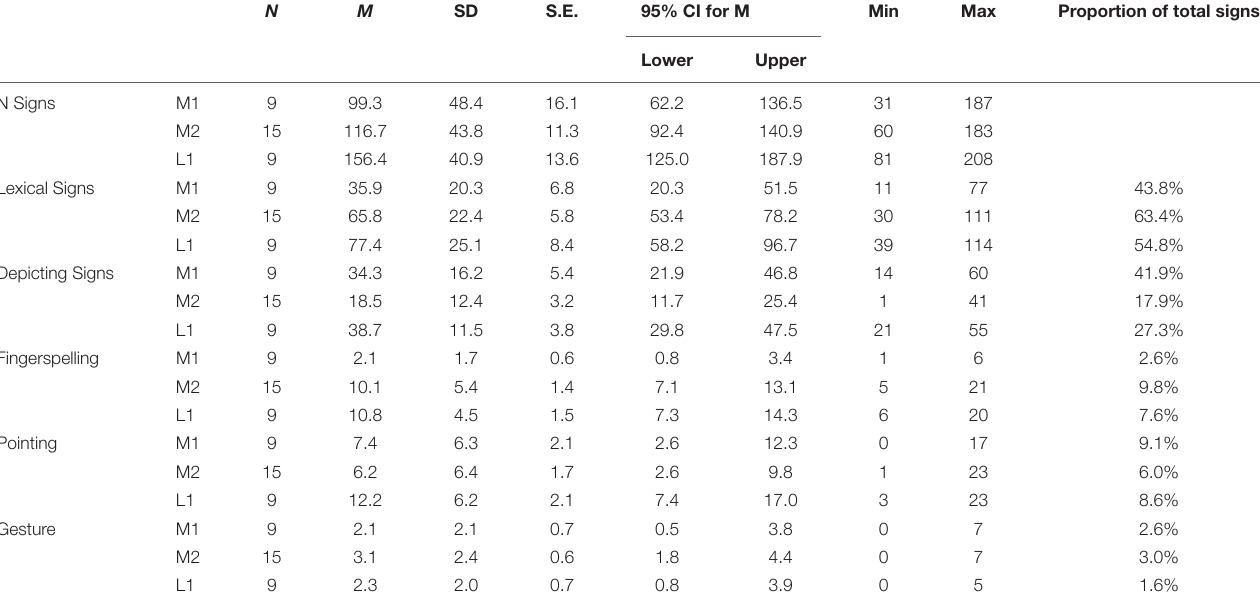
TABLE 3 | Mean frequency and distribution of signs and sign categories [lexical signs, depicting signs (DS), fingerspelling, pointing, and gesture] in group